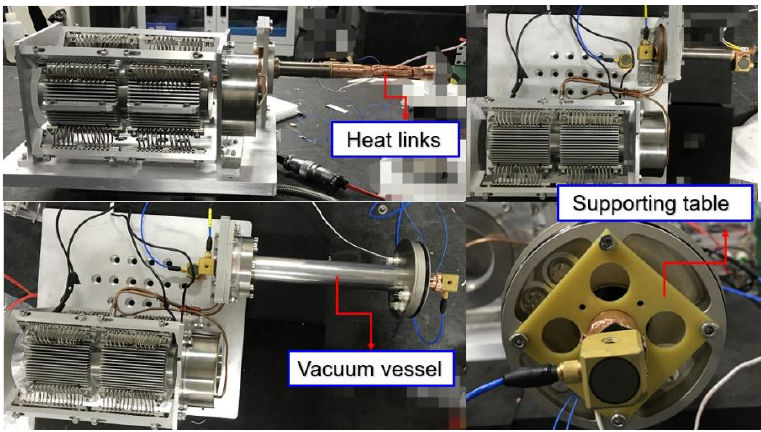
Figure 7. Test configuration for testing VR stage vibration isolation performance.